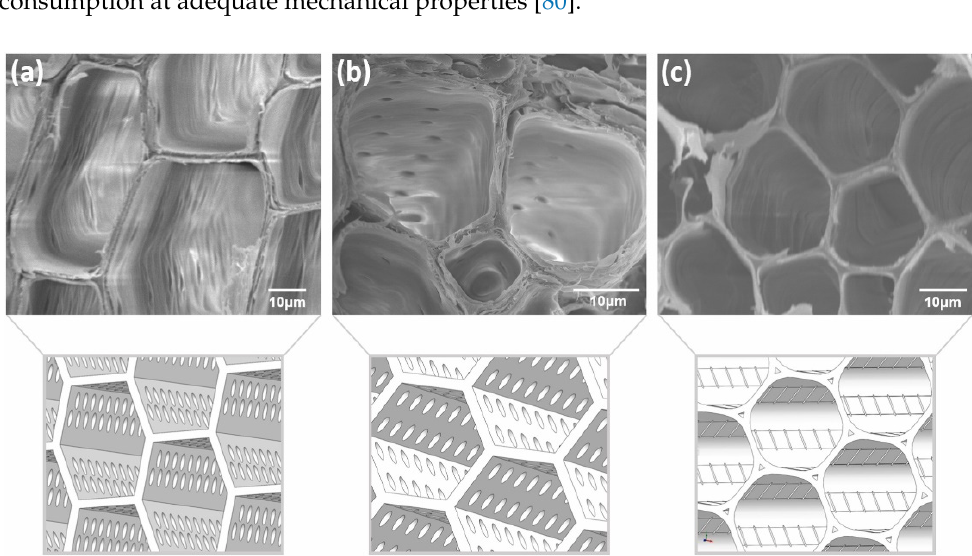
Figure 9. SEM images of wood structure of different wood species (( a ) cedar, ( b ) oak, and ( c ) palm) and 3D models constructed based on these structures. Reprinted from [80] with permission from Elsevier.